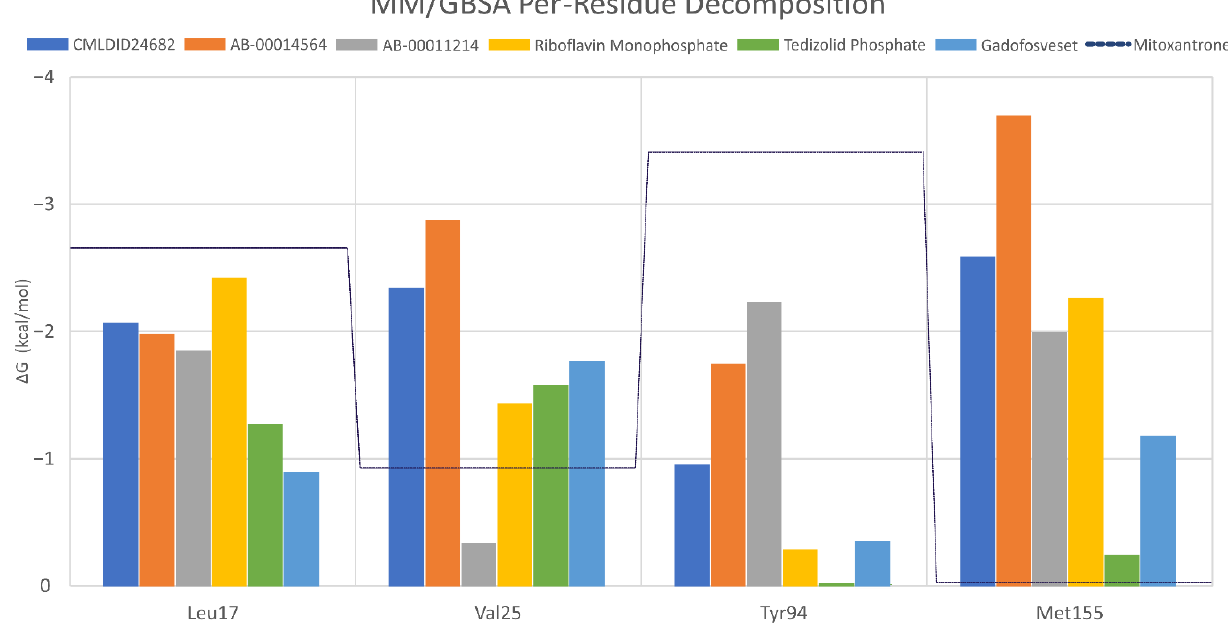
Figure 7. Per-residue decomposition of the free energy calculations using MM/GBSA for the best performing ligands.